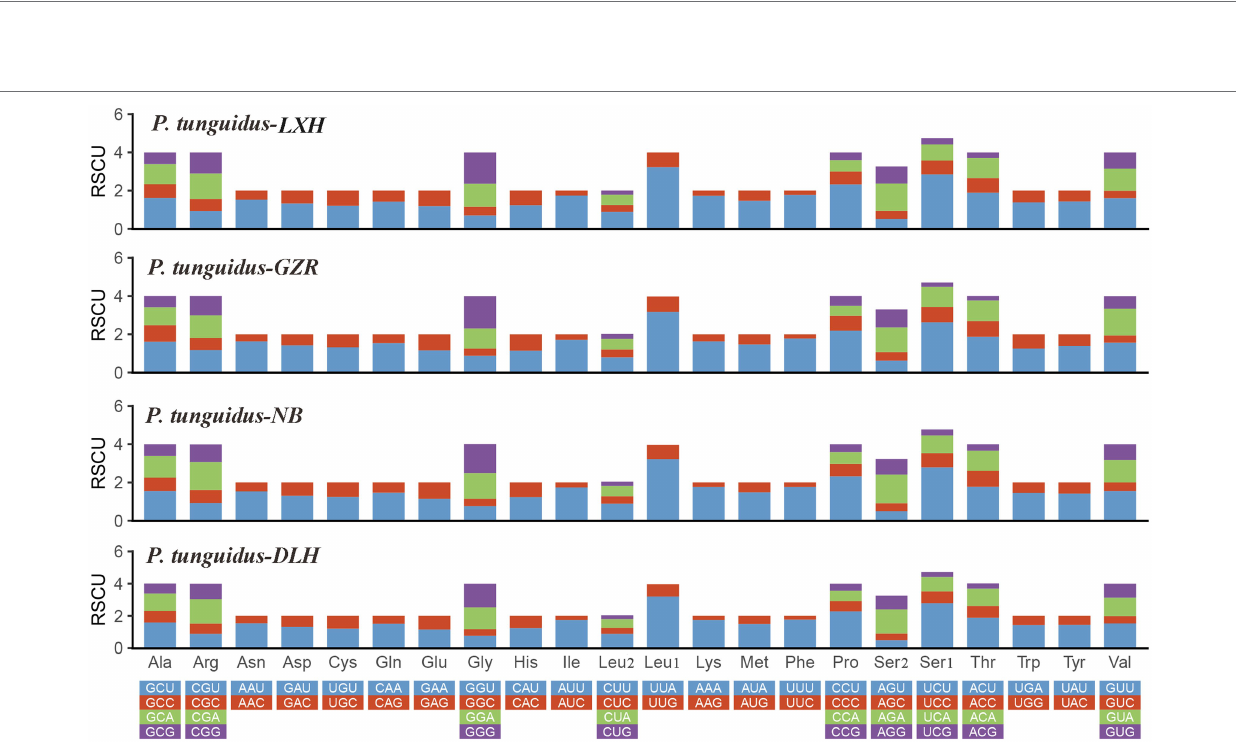
FIGURE 3 | Relative synonymous codon usage in the four representative mitogenomes of P. tunguidus . Codon families are indicated below the X -axis.